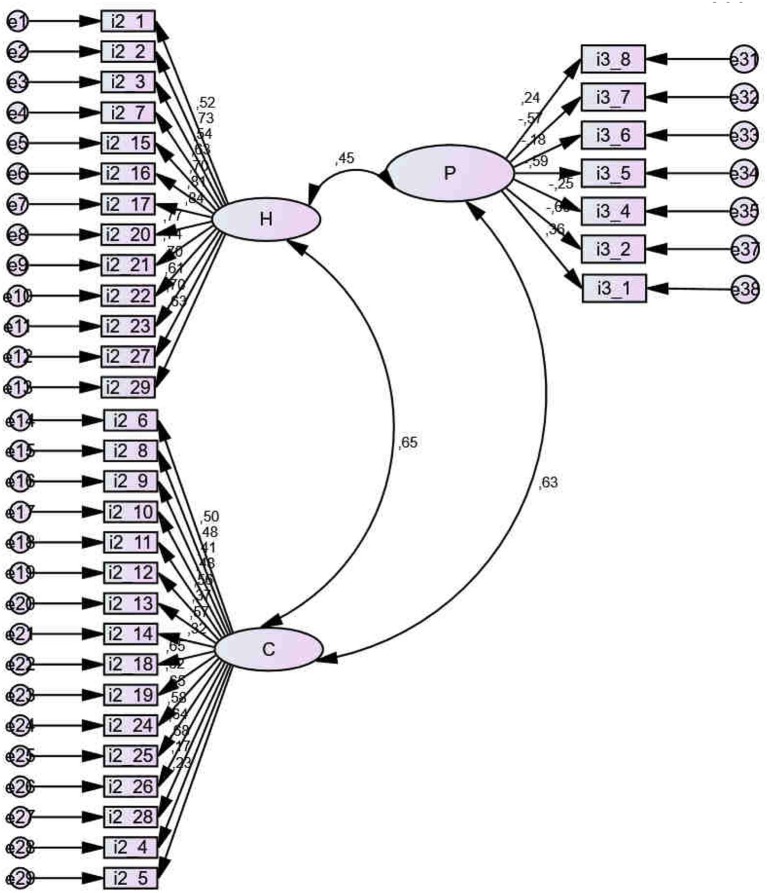
Confirmatory Factor Analysis (CFA) of EHCP scale. H, Facts; C, Concepts; P, Principles.